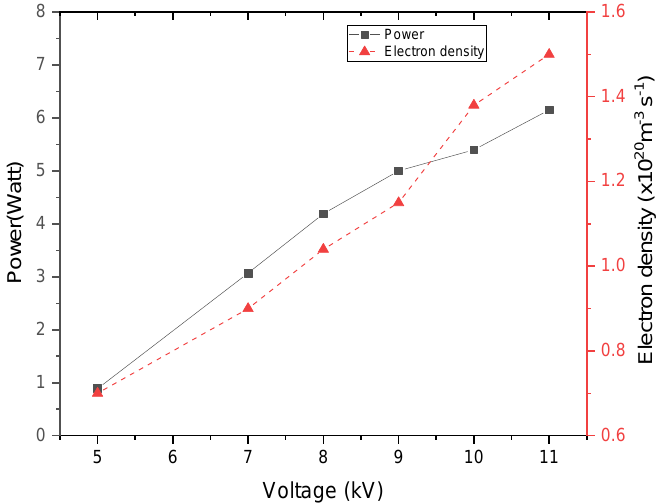
Figure 8. Evolution of the electron density and the electric power consumption with different pulse duration. Voltage magnitude of 10 kV, pulse duration of 1 µs with repetition rate of 10 kHz.